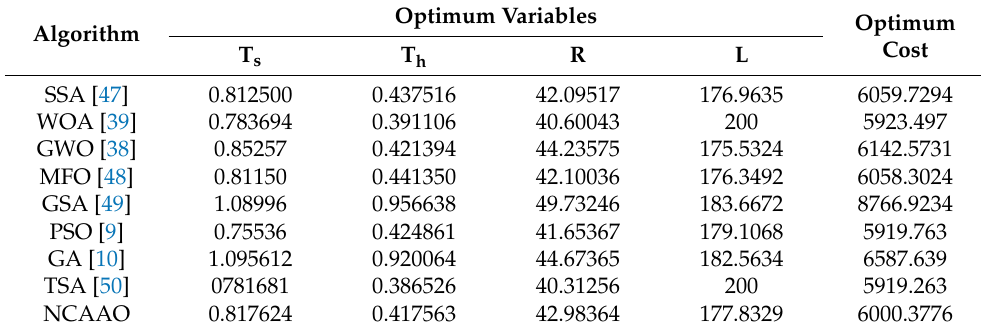
Table 10. Comparison of results for pressure vessel design problem.